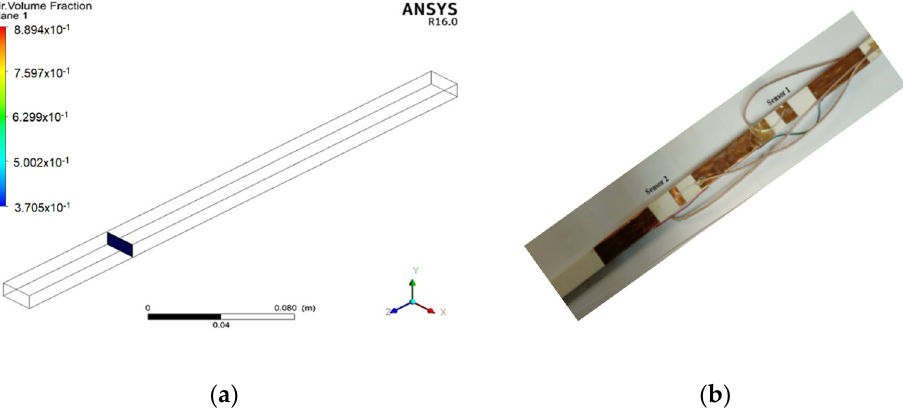
Figure 11. ( a ) Channel for solid particle flow. ( b ) Actual capacitive electrodes for the experimental setup.